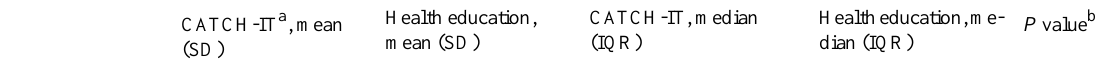
Table 1. Website use, motivational interviews, and participant